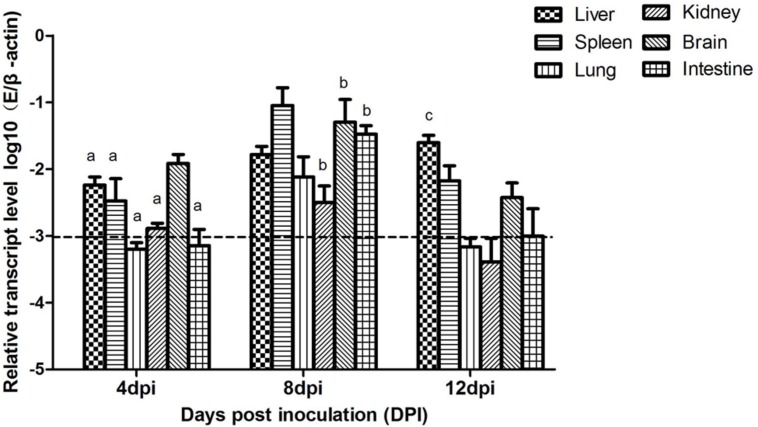
Viral loads in tissues of mice on different days after inoculation by i.c. The relative expression of viral RNA in tissues was determined by SYBR Green I real-time PCR assay (E gene as a target gene and mouse β-actin gene as a reference gene). Each sample was detected in triplicate. Error bars were expressed as standard deviation of the means (n = 3). Data are expressed as the mean log10 (E/β-actin) ± SD. Horizontal dotted line represents viral loads of the control group. Different lowercase letters over the bars denote statistically significant differences (P < 0.05) between different days after infection calculated by the one-way analysis of variance with Tukey’s post-test. (a) 4 dpi vs. 8 dpi; (b) 8 dpi vs. 12 dpi; (c) 4 dpi vs. 12 dpi.